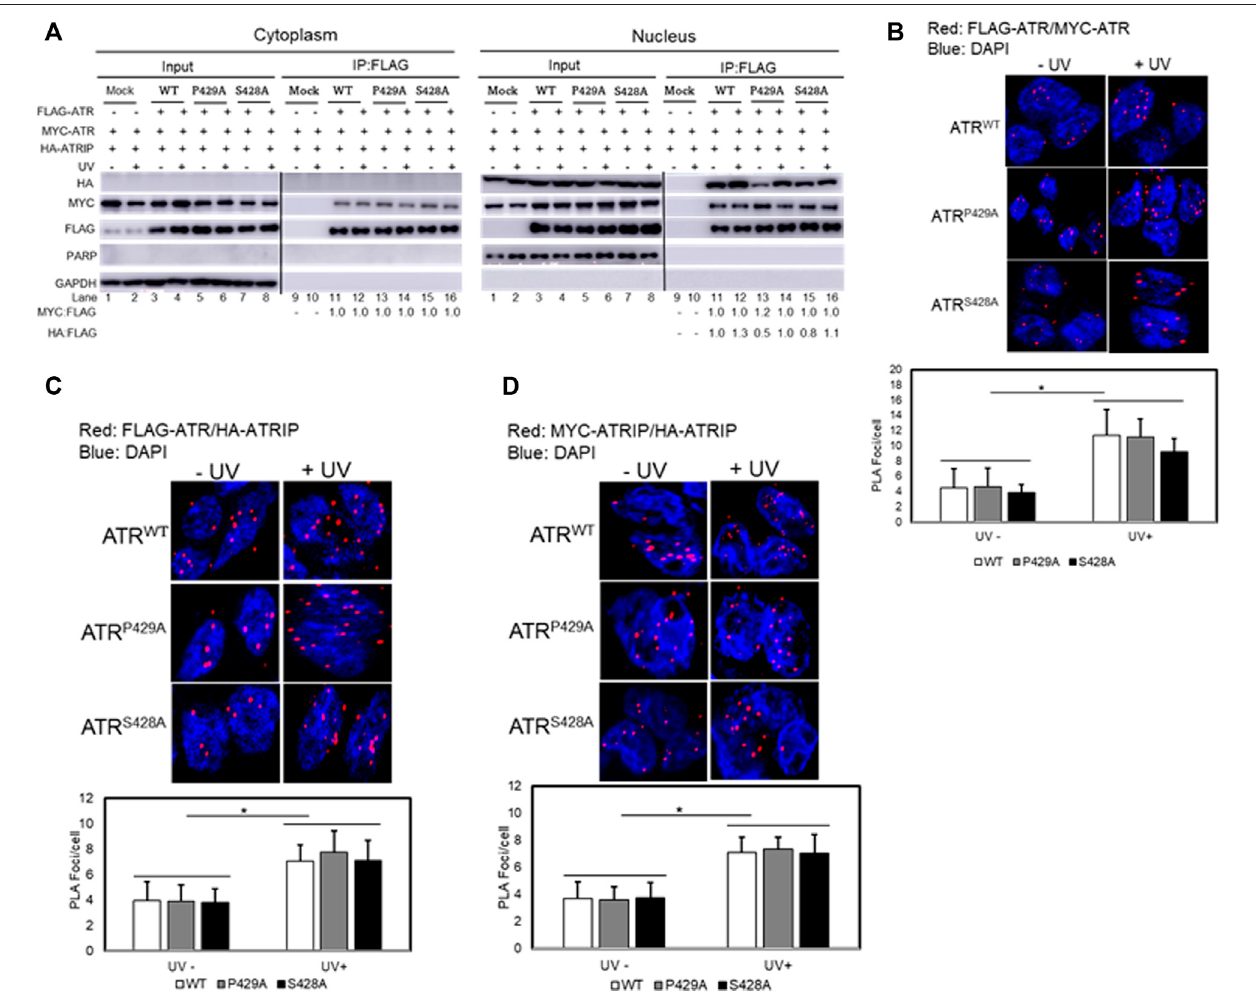
FIGURE4| Effectof cis/trans isomerizationonATRoligomerizationandATR – ATRIPcomplexformation. (A) Oligomerizationof trans- and cis- ATRwasanalyzedby co-expressing vector constructs encoding FLAG-ATR, Myc-ATR, and HA-ATRIP transfected into the ATR fl ox/ − cells followed by UV+/ − treatments. ATR oligomerization was assessed by co-immunoprecipitation after cellular fractionation. Interestingly, no ATRIP occurred in the cytoplasm as compared to ATRIP in the nucleus. The Myc/ FLAG ratios were normalized to the ratio at lane 11 (cytoplasm fraction) and HA/FLAG at lane 11 (Nuclear fraction). (B) PLA revealing a direct interaction between FLAG-ATRandMyc-ATRinATR fl ox/ − cellsco-transfectedwithFLAG-ATRandMyc-ATRplasmids.TheinteractionwasenhancedafterUVirradiationat40 J/m 2 .ADAPI- staining overlay shows the location of the nuclei. (C) ATR/ATRIP complex formation was monitored using PLA by co-transfecting FLAG-ATR WT, P429A, or S428A mutant with Myc-ATRIP in ATR fl ox/- cells. (D) ATRIP oligomerization in the presence of FLAG-ATR WT, P429A, or S428A mutant proteins. ATR fl ox/- cells were co- transfected with Myc- and HA-ATRIP plus FLAG-ATR WT, P429A, or S428A constructs followed by UV irradiation. Oligomerization of Myc- and HA-ATRIP was monitoredbyPLA.Fociformationpercellswascalculatedconsideringanaverageof50cells,andeachexperimentwasperformedintriplicate.Thebargraphsrepresent the statistical analysis of the PLA images. * stands for the p -value <